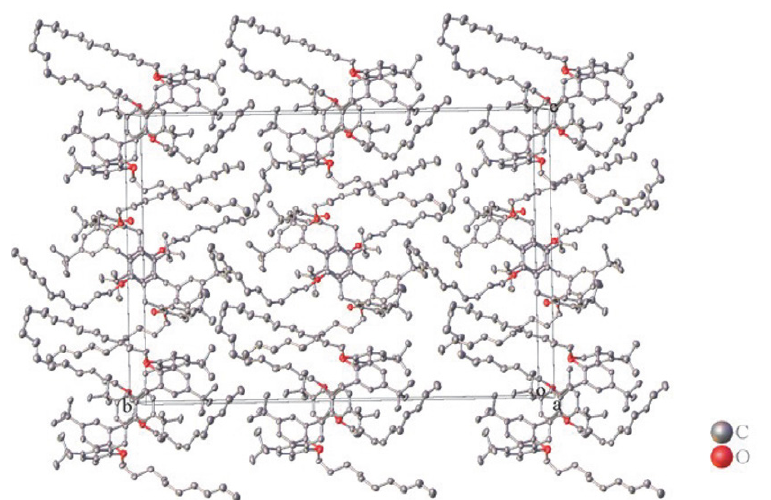
Fig. 1. Molecular structure of the C6A-C10-OH